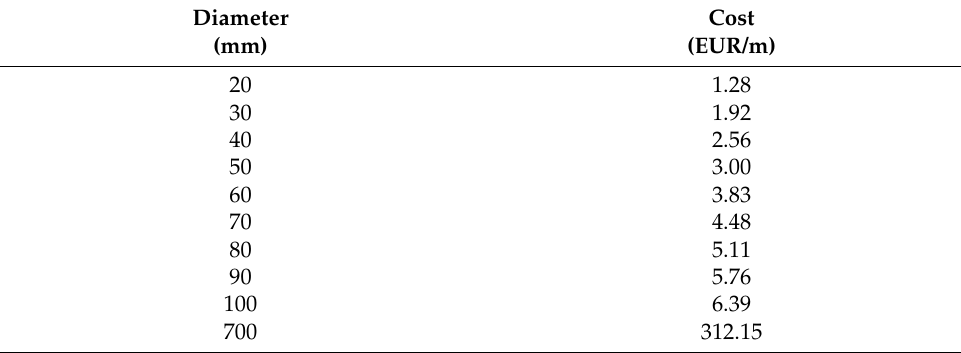
Table 9. Results for the Balerma network. Table 8. Additional available diameters for the Balerma